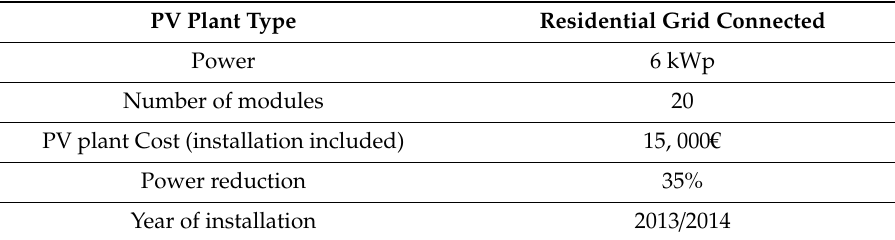
Table 14. PV plant data.